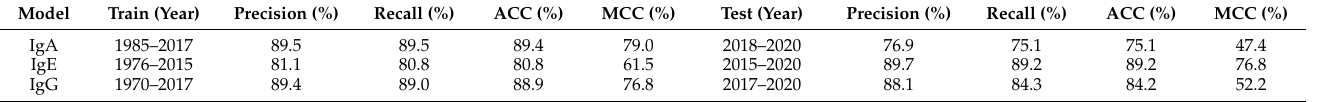
Table 5. Test results of the IgA, IgE, and IgG models using data from previous years. Model